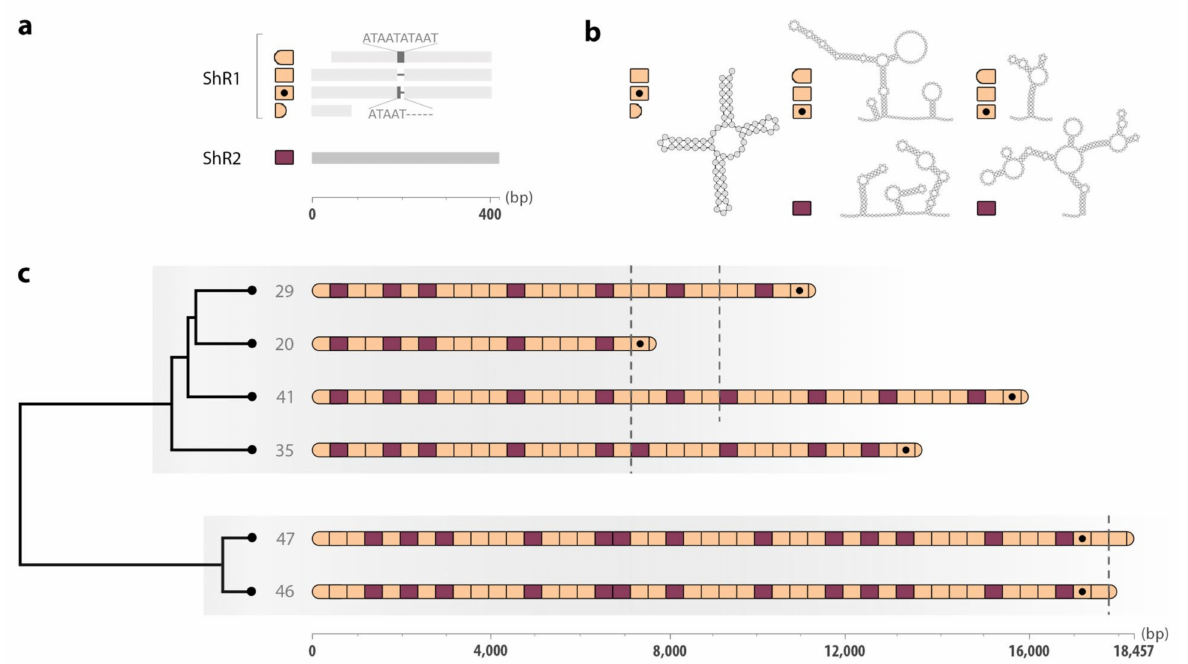
Figure 3. Structure of the tandem-repeat regions in the mitochondrial (mt) genomes of Schistosoma haematobium . ( a ) A schematic representation of the units ShR1 (orange) and ShR2 (purple). Insertions of 5 (cid:48) -ATAAT-3 (cid:48) motifs within a TA-rich region in ShR1s are indicated. Scale in base pairs is shown at the bottom. ( b ) Secondary structures predicted for ShR1 and ShR2 (units in which they occur are indicated on the left of the structure). ( c ) A schematic representation of the hierarchical cluster analysis of repeat unit patterns (cf. Figure S3). Orange and purple shapes correspond to units ShR1 and ShR2 in panels ( a ) and ( b ). Grey numbers at branch tips correspond to the number of units. Lineage 1 (top) and 2 (bottom) are shaded in grey. Dashed lines demarcate the end of common repeat unit patterns within lineages. Scale in base pairs is shown at the